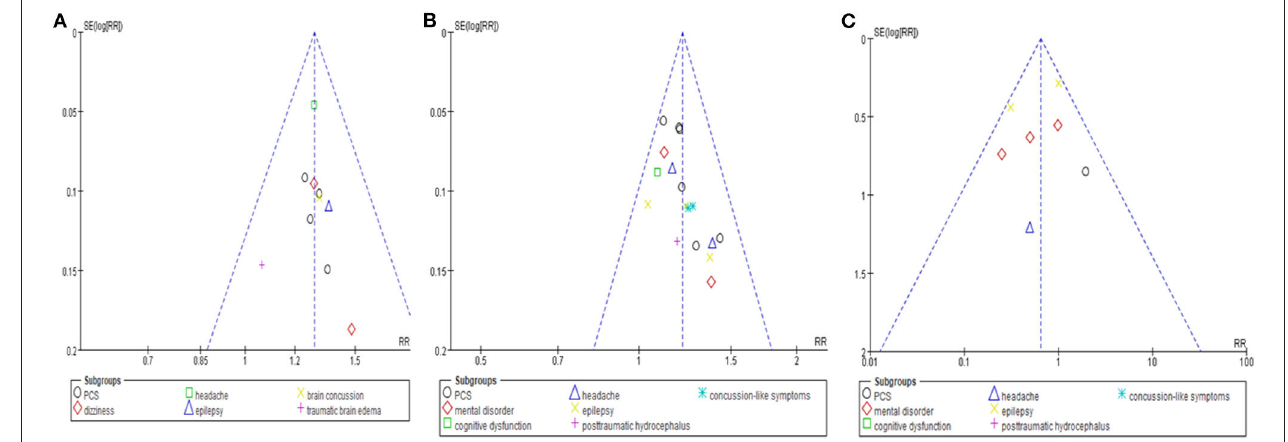
FIGURE 7 | Funnel plots of the meta-analysis. (A) Total effective rate based on clinical symptom. Comparison: herbal medicine vs. conventional treatment. (B) Total effective rate based on clinical symptom. Comparison: herbal medicine combined with conventional treatment vs. conventional treatment. (C) Adverse events. Comparison: herbal medicine combined with conventional treatment vs. conventional